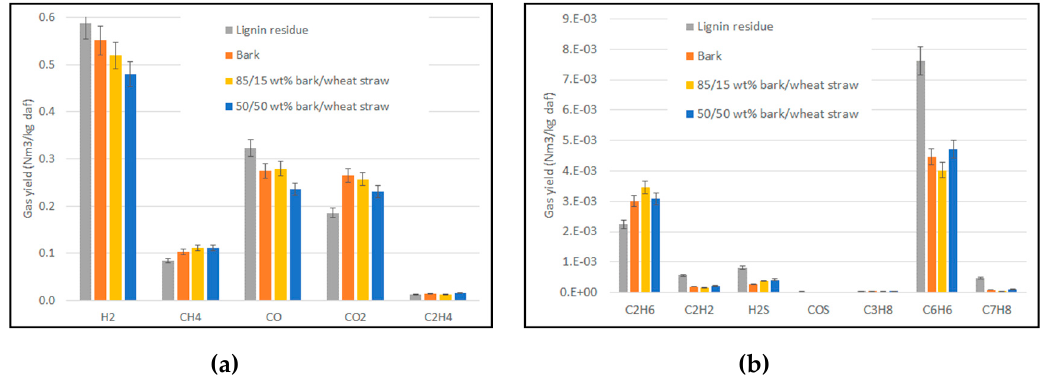
Figure 5. Mean gas species yields for the gasification tests, ( a ) major species, ( b ) minor species.